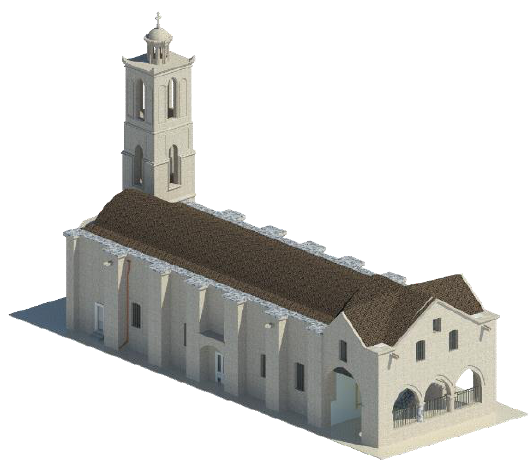
Figure 16. HBIM Model of the Saint John Cathedral